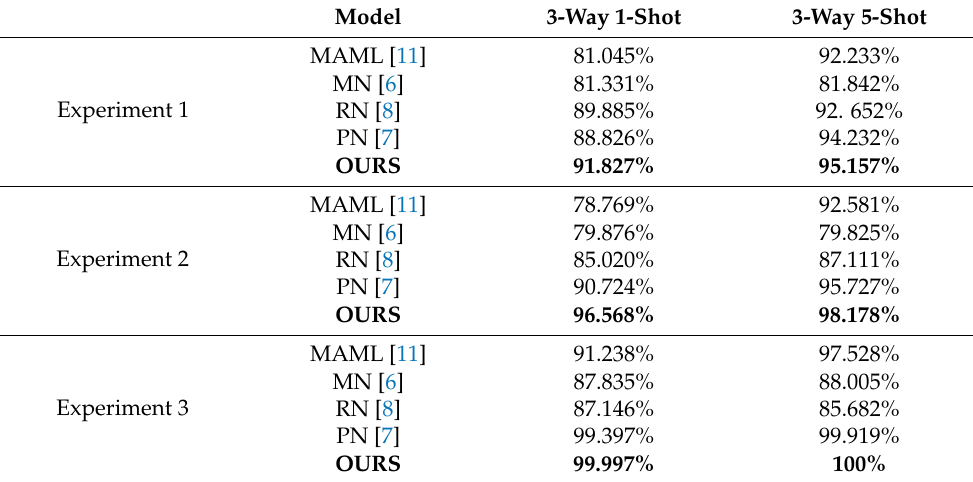
Table 3. Classification accuracies on closed-set few-shot